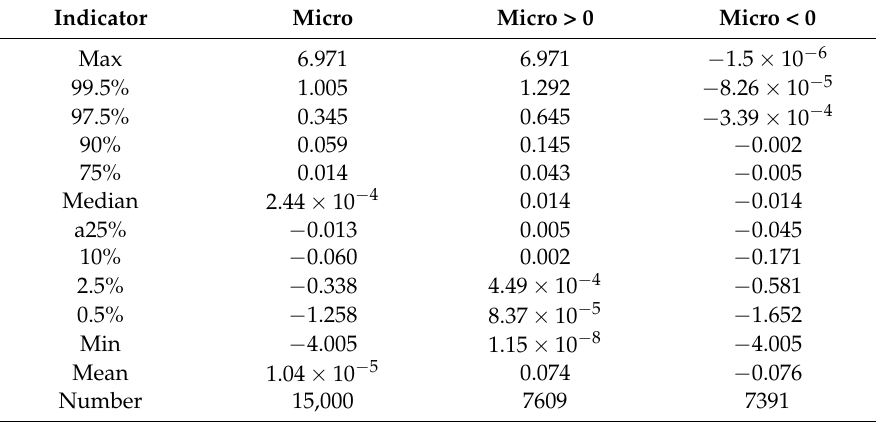
Table 2. Statistical indicators for micro-texture with spikes.